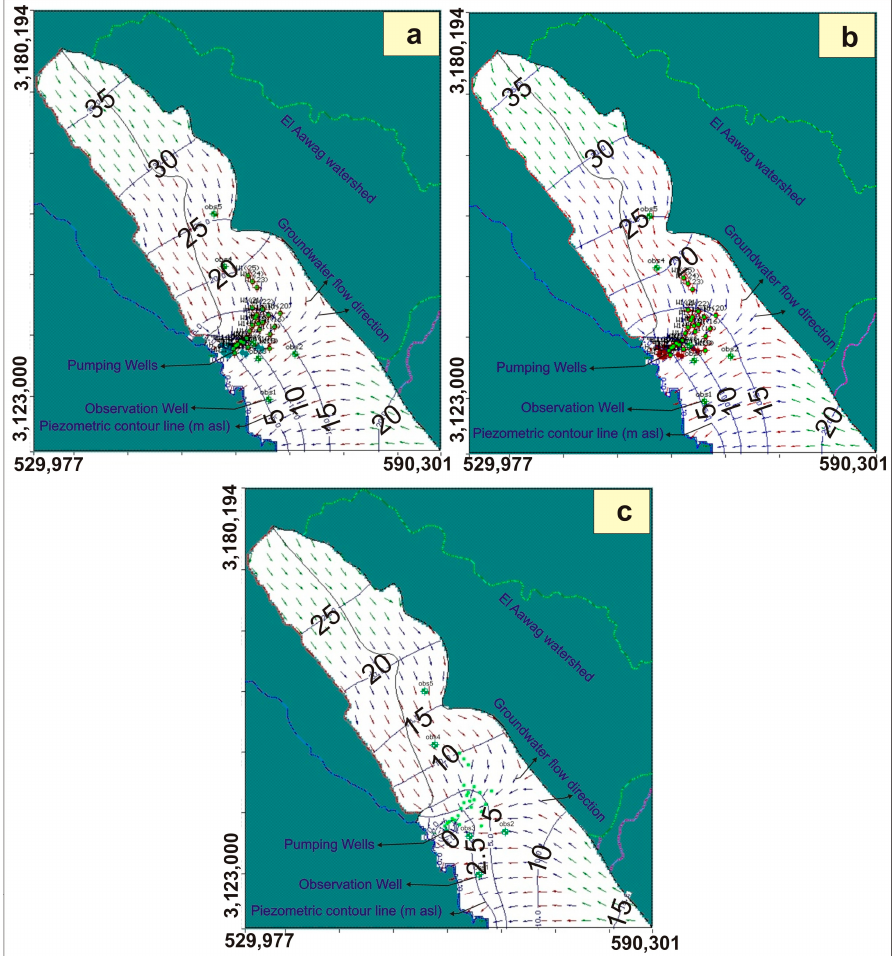
Figure 13. Flow direction and piezometric heads: ( a ) scenario No. 3; ( b ) scenario No. 4; ( c ) scenario No. 5.